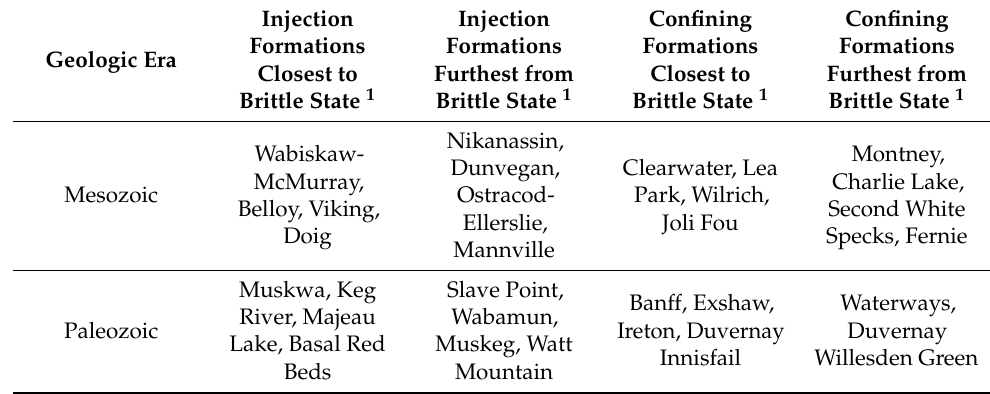
Table 6. Alberta Basin injection and confining formations closest and furthest from the brittle state in situ (based on available historical in situ stress state and pore pressure